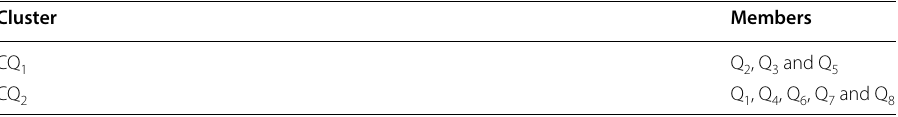
Table 10 Solution space